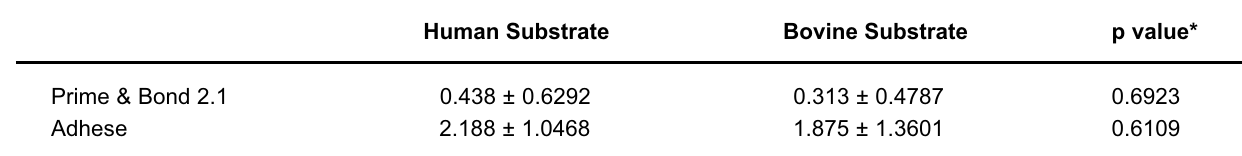
* Mann-Whitney U test (p>